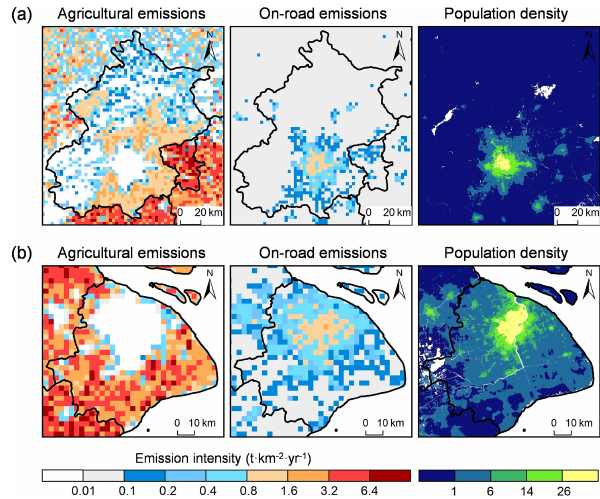
Figure 6. Spatial distribution of agricultural and on-road NH 3 emission intensities and population density in (a) Beijing and (b) Shanghai in